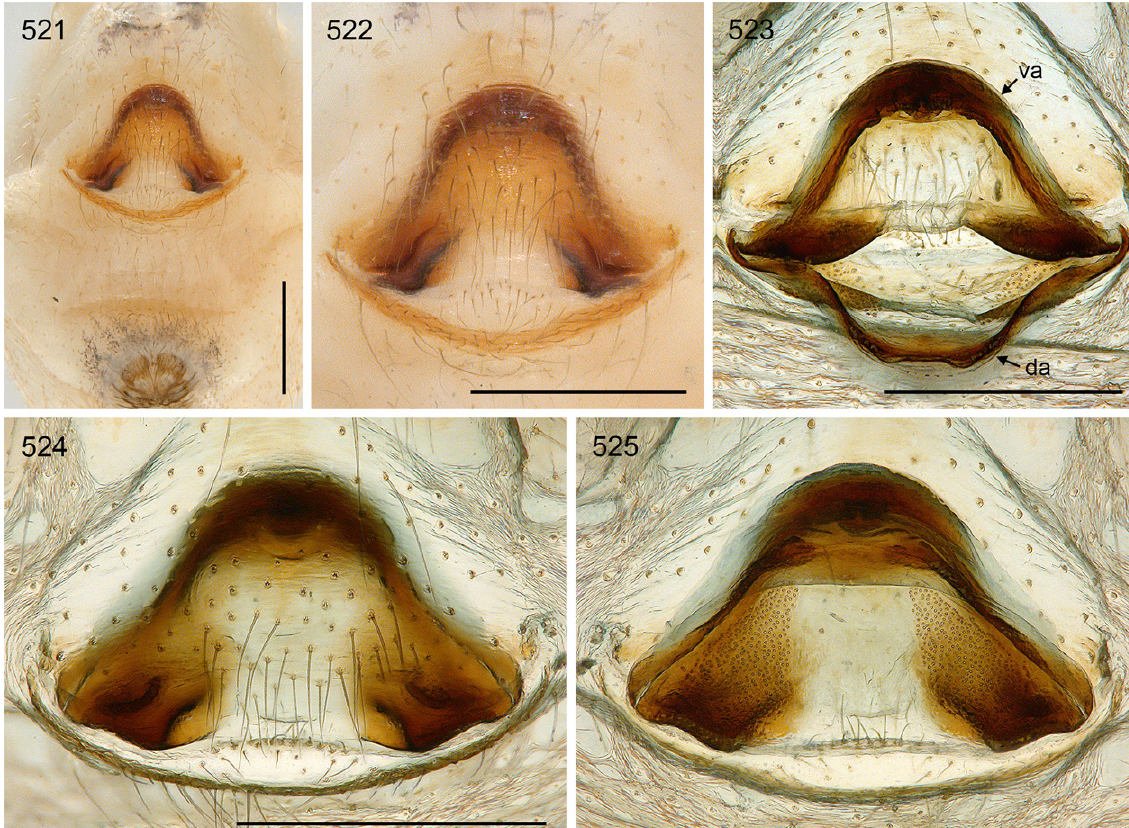
Figs 521–525. Crossopriza kittan sp. nov.; female from Oman, Ibri, Al Kittan Cave (ZFMK Ar 22425). 521–522 . Abdomen and epigynum, ventral views. 523–525 . Female internal genitalia, dorsal view (with dorsal arc tilted backwards), ventral view, and regular dorsal view. Abbreviations: da = dorsal arc; va = ventral arc. Scale bars = 0.5